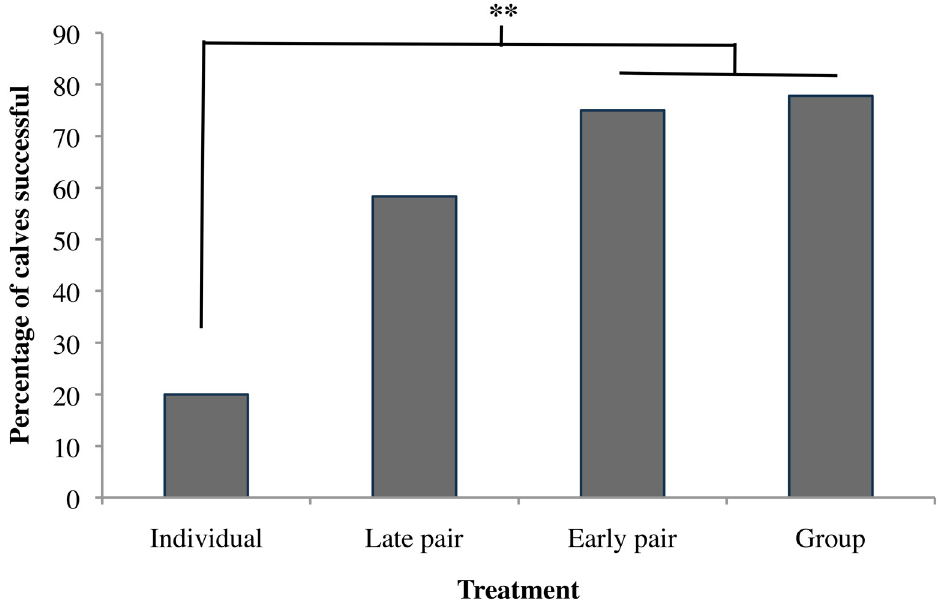
PLOS ONE | DOI:10.1371/journal.pone.0132828 August 14,